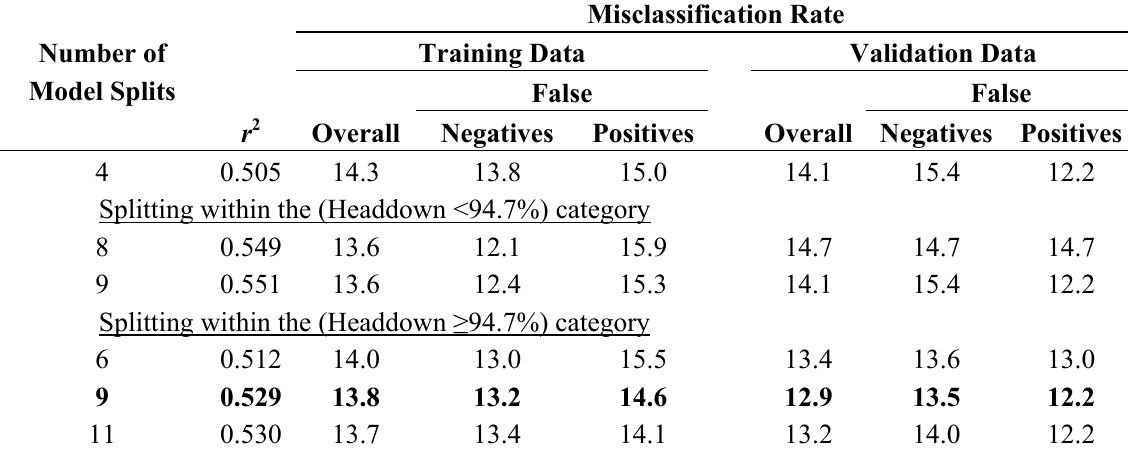
Table 1. Misclassification rates for binary classification trees differentiating between cattle grazing and non-grazing activities based upon synchronized GPS collar and direct observation data collected for yearling steers grazing shortgrass steppe in eastern Colorado during 2008–2011. The final selected model is shown in bold, and presented in Figure